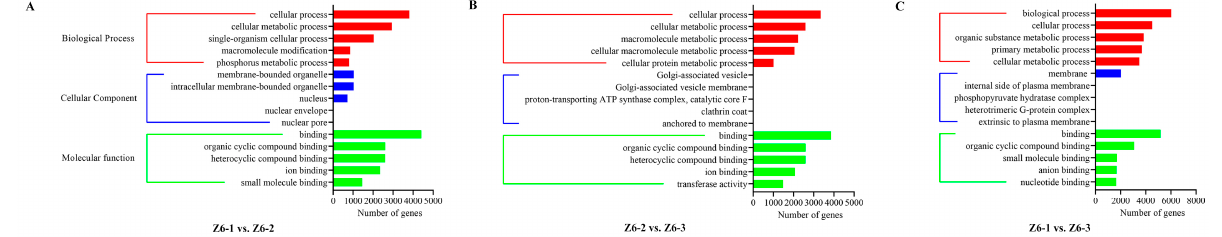
Figure 8. GO enrichment analysis of target genes of differentially expressed miRNAs on pairwise comparisons. ( A ) Comparison of Z6-1 vs. Z6-2. ( B ) Comparison of Z6-2 vs. Z6-3. ( C ) Comparison of Z6-1 vs. Z6-3.